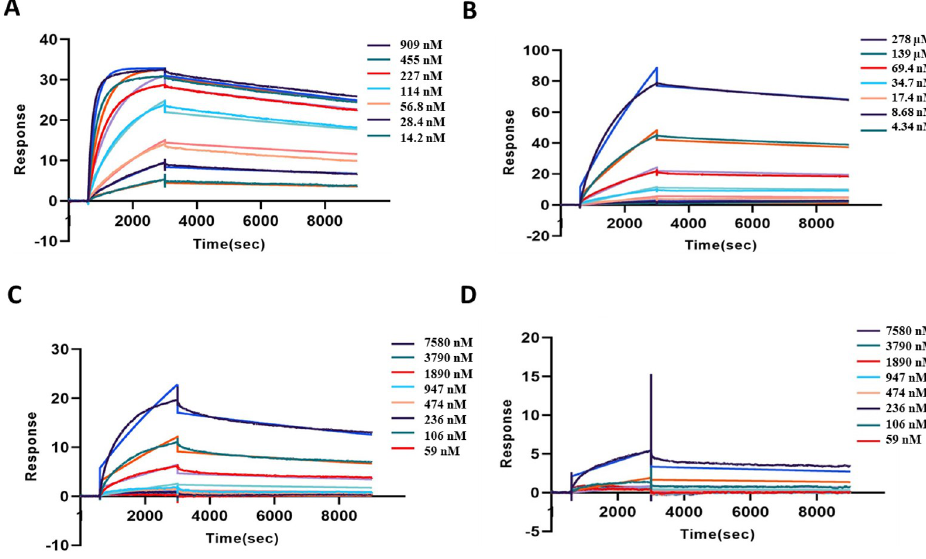
Fig 3. SPR Sensograms to measure the binding affinity of AB1 towards venom components. Panels A to D . Different concentrations of peptide-II of CTX-7, rCTX-7, cobra venom, and krait venom were taken as indicated and change in the corresponding sensograms were recorded using Surface Plasmon Resonance,